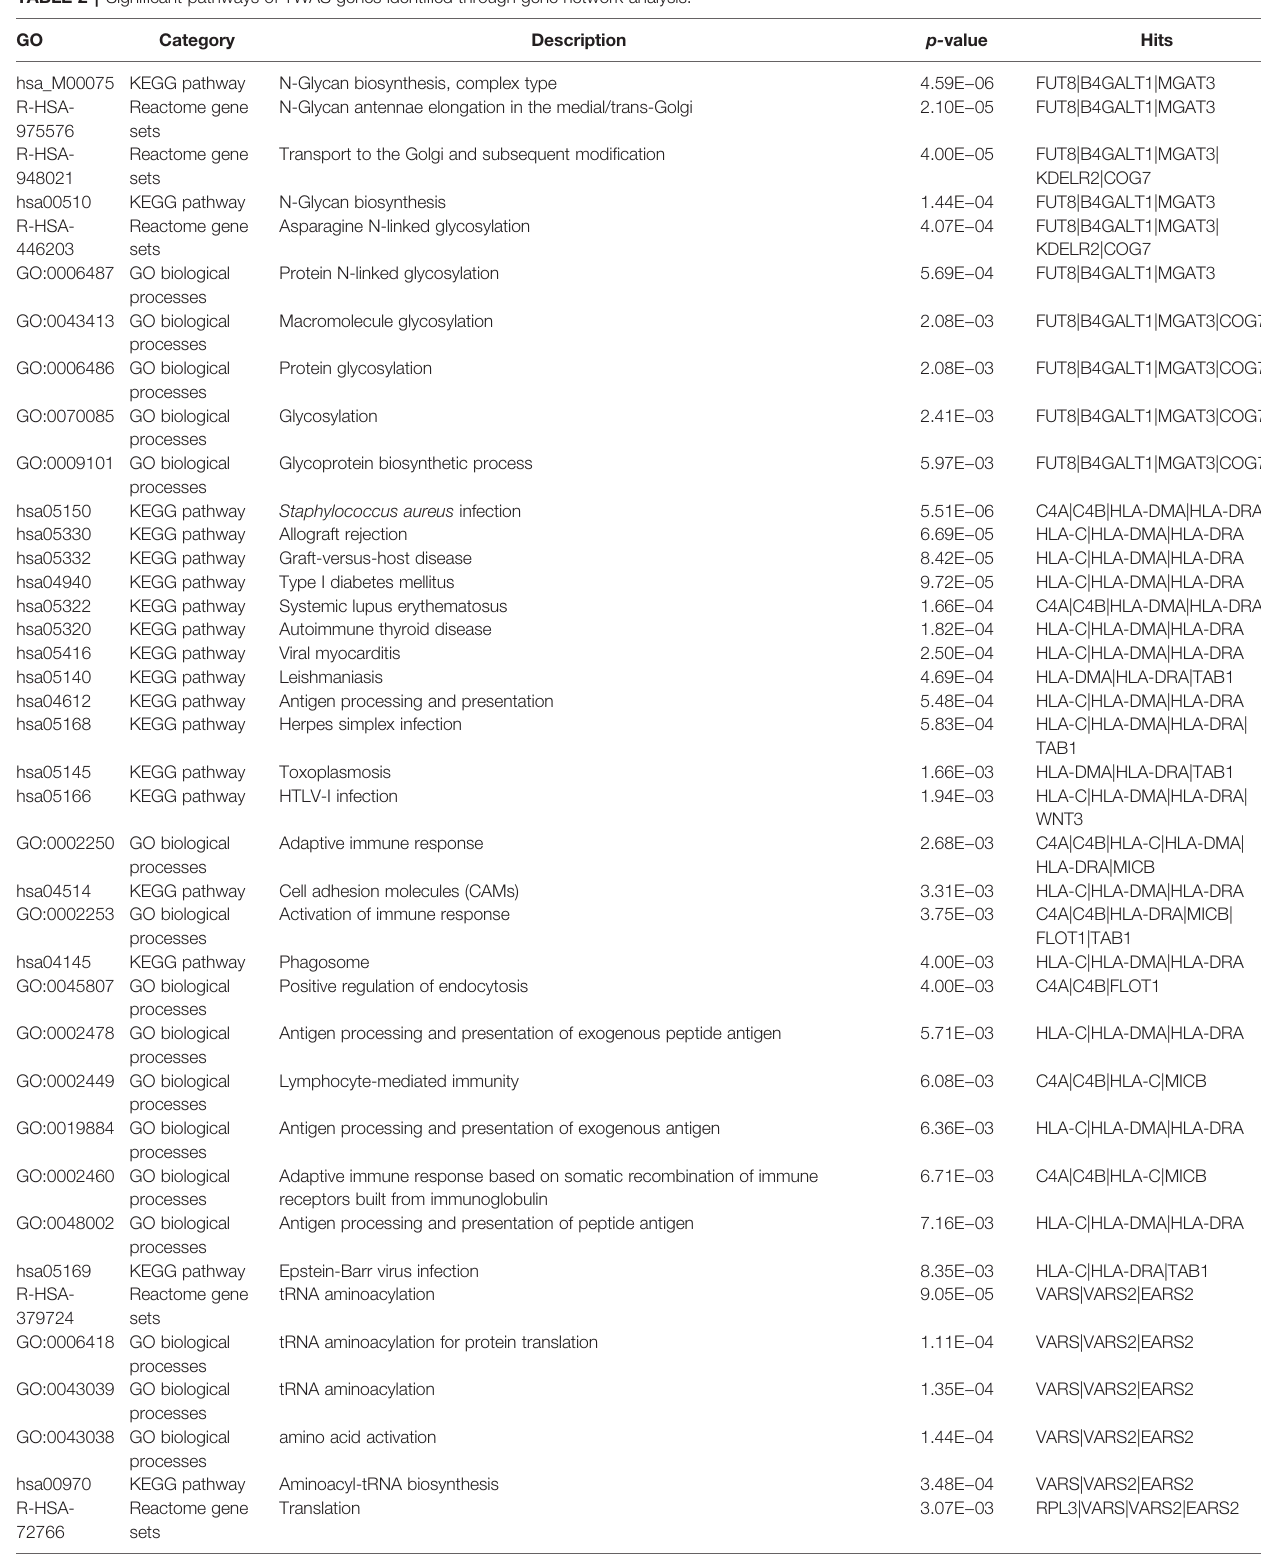
TABLE 2 | Signi fi cant pathways of TWAS genes identi fi ed through gene network